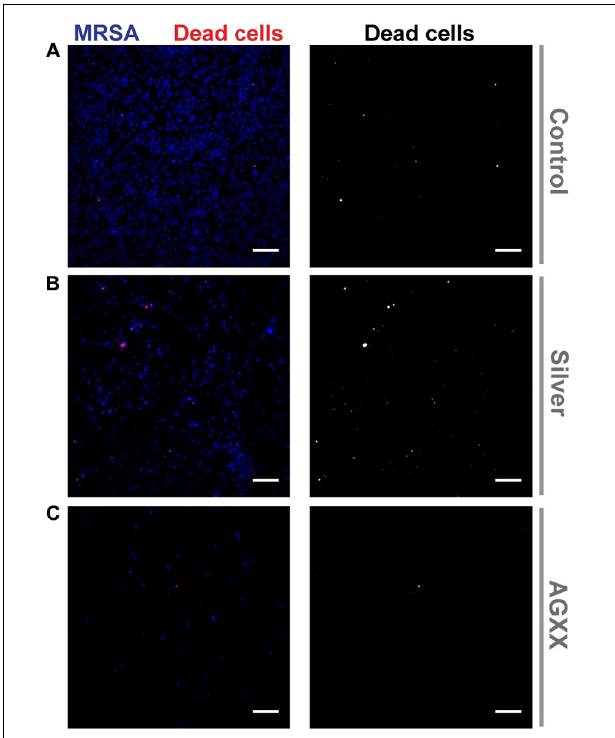
FIGURE 2 | Confocal images of biofilm formation by S. aureus 04-02981 (MRSA). The pathogen was grown on sterile cover slips for 24 h with the following conditions: (A) without antimicrobial sheet, (B) with a silver sheet or (C) with an AGXX R (cid:13) sheet. Biofilms were then stained with Hoechst 33342 (to mark out S. aureus 04-02981; blue) and propidium iodide (to identify dead cells; red) followed by acquisition of small Z -stacks (500 nm spacing) through the biofilms using a confocal microscope. Images show an average of Z-projection (average of 4–5 Z planes containing the biofilm) of the fluorescence signal through the biofilms with the propidium iodide staining shown alone in the images on the right (gray scale images). Scale bars = 10 µ m.